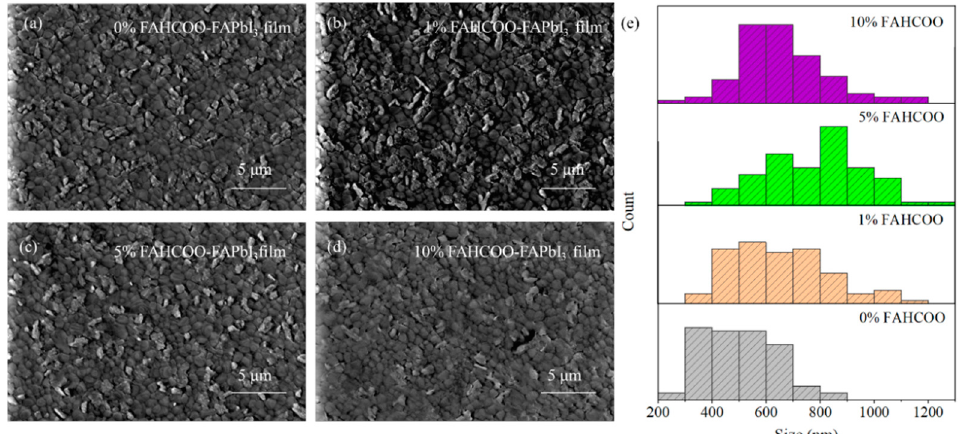
Figure 3. SEM comparison of FAPbI 3 films prepared with different amounts of FAHCOO. ( a ) SEM image of 0% FAHCOO FAPbI 3 film. ( b ) SEM image of 1% FAHCOO FAPbI 3 film. ( c ) SEM image of 5% FAHCOO FAPbI 3 film. ( d ) SEM image of 10% FAHCOO FAPbI 3 film. ( e ) Diameters statistical diagrams of 85 grains of FAPbI 3 films.